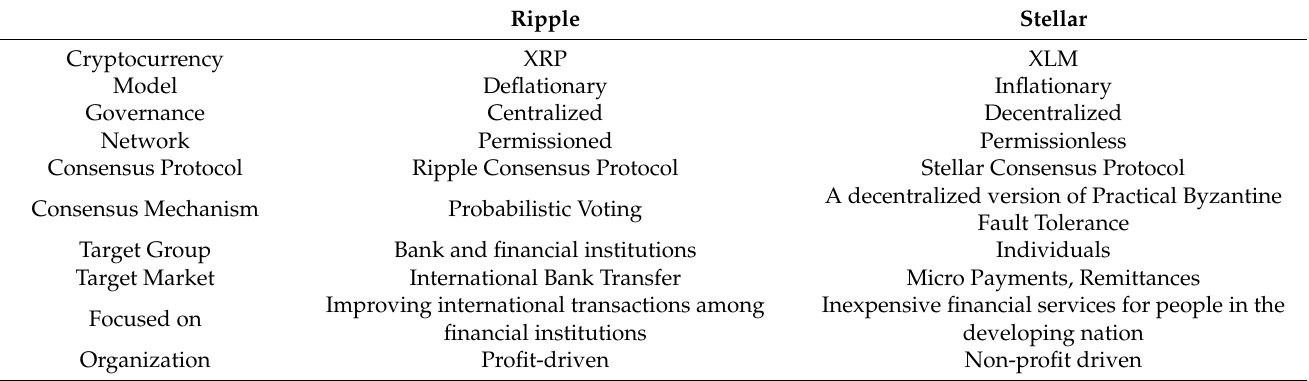
Table 1. Comparison between Ripple and